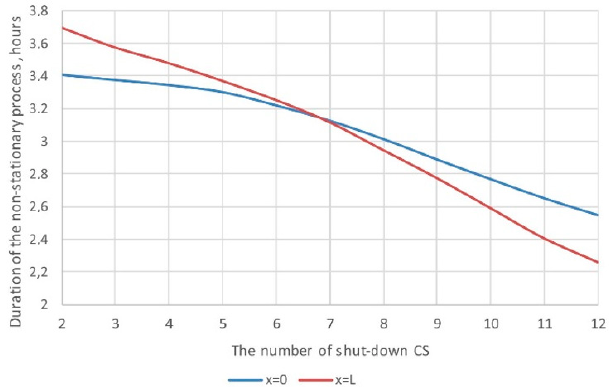
Figure 5. Duration of the unsteady process caused by disconnection of compressor stations for the initial ( x = 0) and final ( x = L ) cross-section of the gas pipeline.